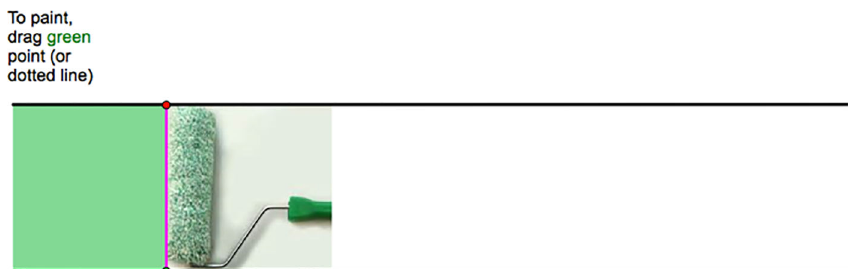
Figure 10. Paint roller